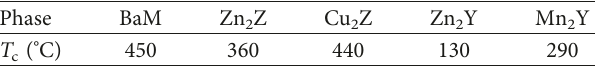
Figure 8: Thermomagnetic curves and their derivatives for the Ba Table 5: Curie temperature T ° C) for the hexaferrite phases c ( observed in the samples [48].